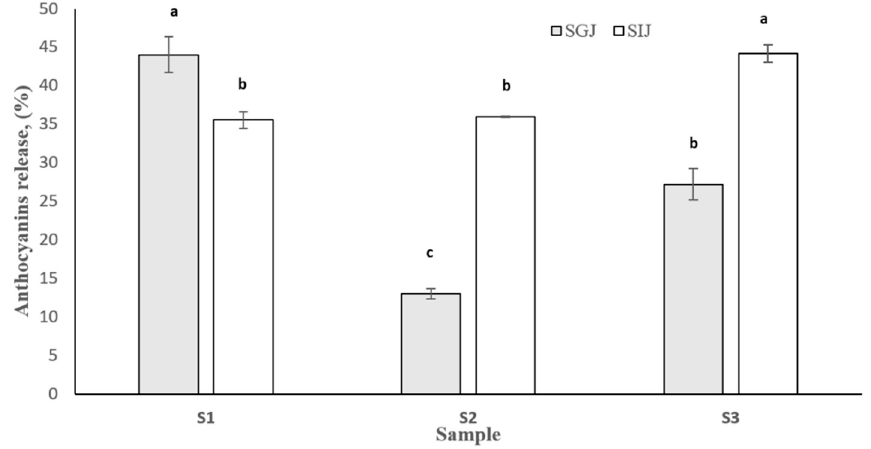
Figure 4. Anthocyanins release after 2 h of incubation with SGJ and SIJ. For the same simulated juice, samples not sharing the same letter (a, b, c) are statistically significant at p < 0.05 based on the post-hoc Tukey test.